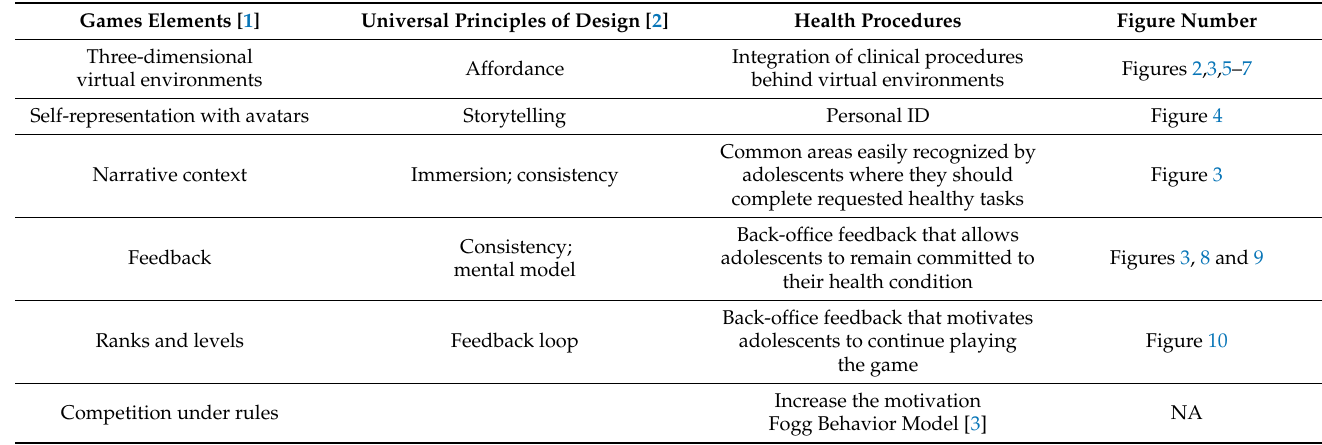
Table 1. Strategy for pairing game elements design with health